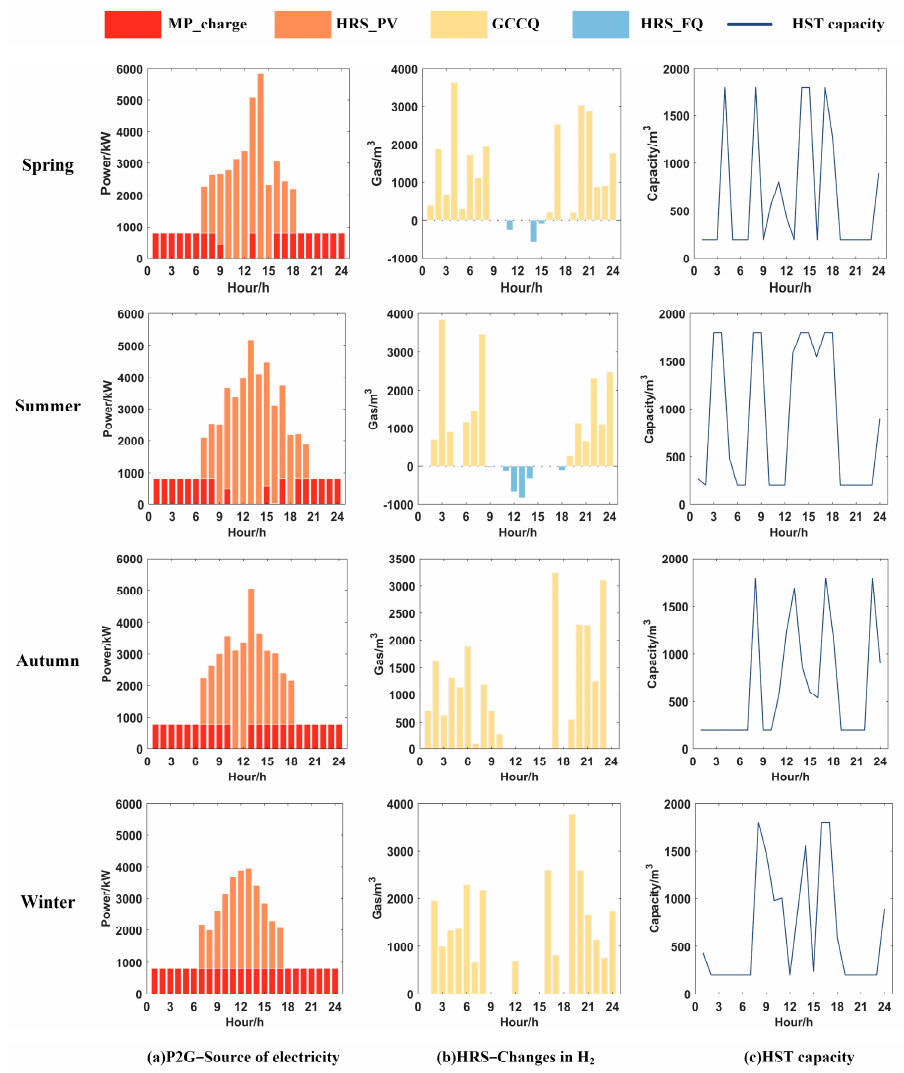
Figure 10. HRS optimization results − Scenario 4.